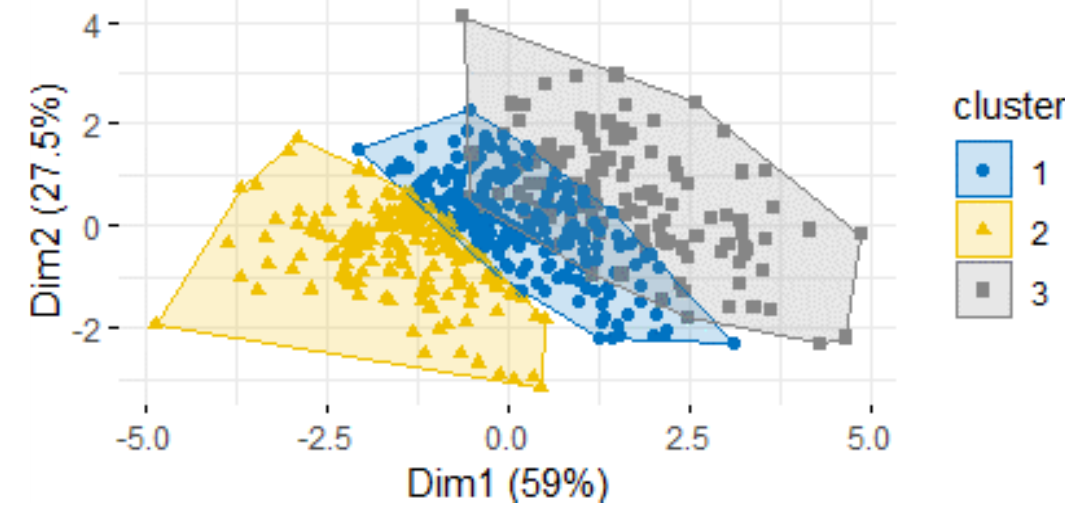
Figure 2. K − Medoid Method Clustering with k = 3 clusters.